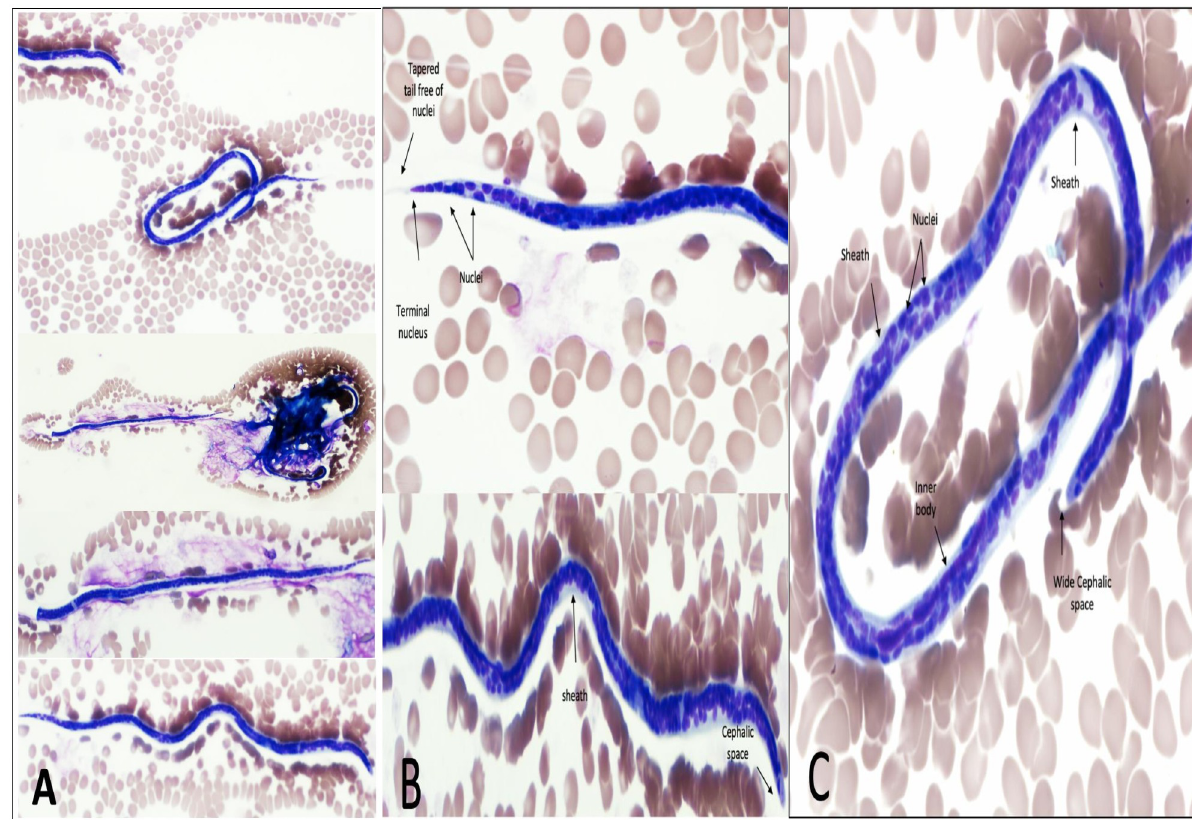
Fig 1. Microphotographs of Wuchereria bancrofti microfilaria in a peripheral blood smear. Thin blood film Giemsa stain, 100 × . (A) Full-size microfilaria × 10 (B) head, body, and tail details. (C) Body and tail